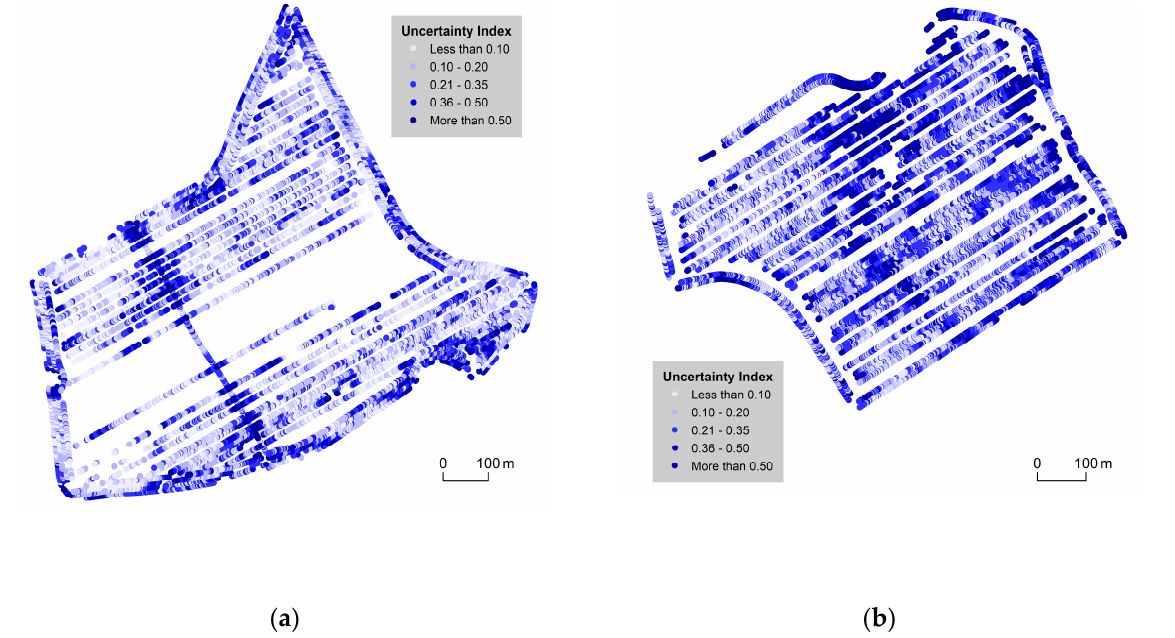
Figure 8. Lightness applied to quantitative data on uncertainty for P ř ední Prost ř ední ( a ) and Pivovárka ( b ).